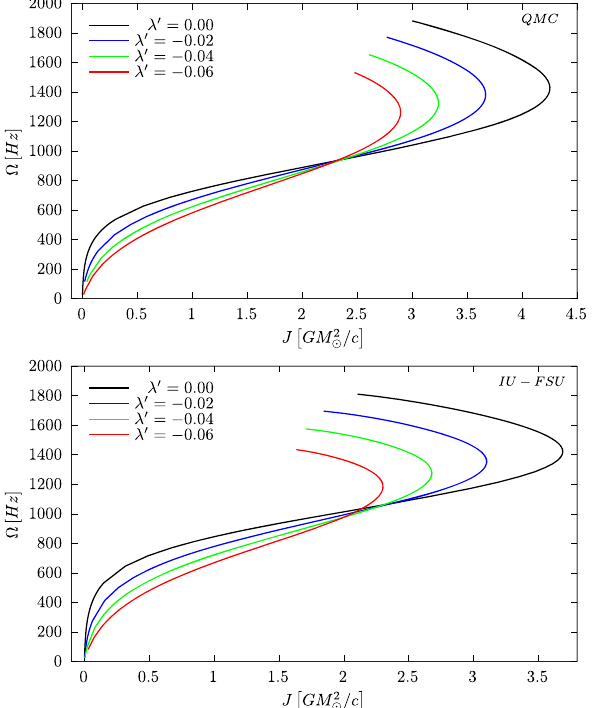
Fig. 5 The moment of inertia as a function of the mass for sequences of stars rotating at 300 Hz (dash double-dot curves), stars rotating at 716 Hz (dash-dot curves) and for stars rotating at the mass-shedding limit (solid line curves). The curves for λ (cid:6) = 0 correspond to the GR